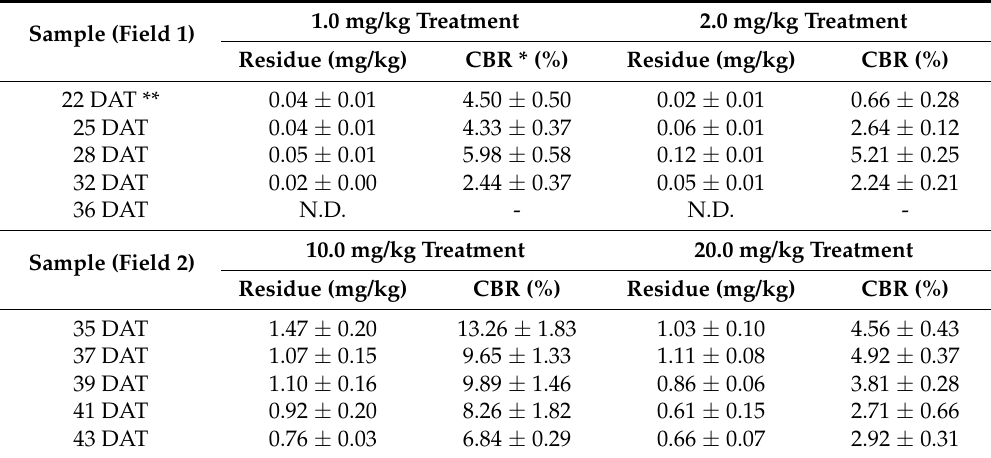
Figure 1. Dissipation of chlorpyrifos in the treated soils. ( A ) Soil samples from field 1; ( B ) Soil samples from field 2. Table 3. Residue levels of chlorpyrifos in lettuce grown in treated